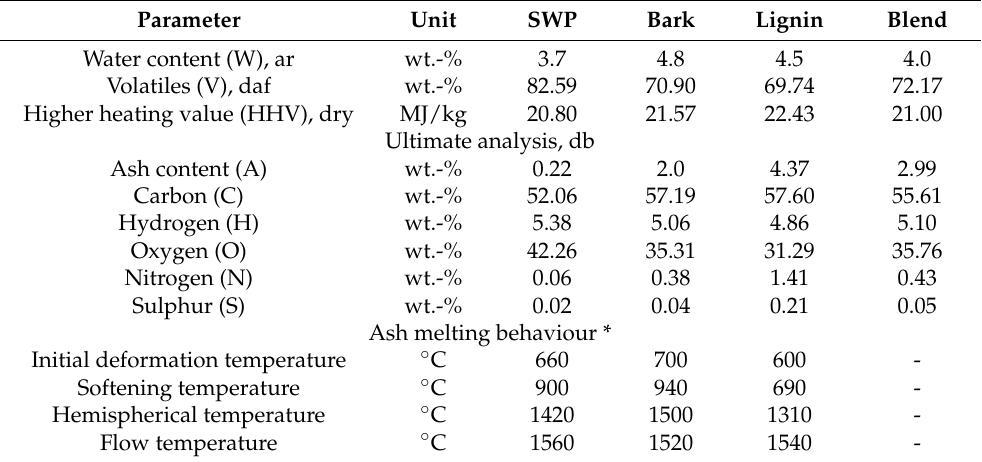
Table 1. Proximate and ultimate analysis of gasified feedstocks.